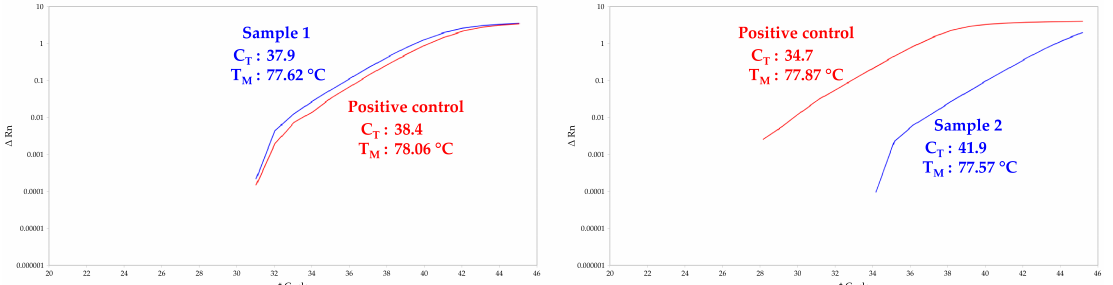
Figure 2. RT-qPCR amplification plots from the two positive feeding membrane samples. In blue, the amplification curves of each sample; in red, the amplification curves of positive control